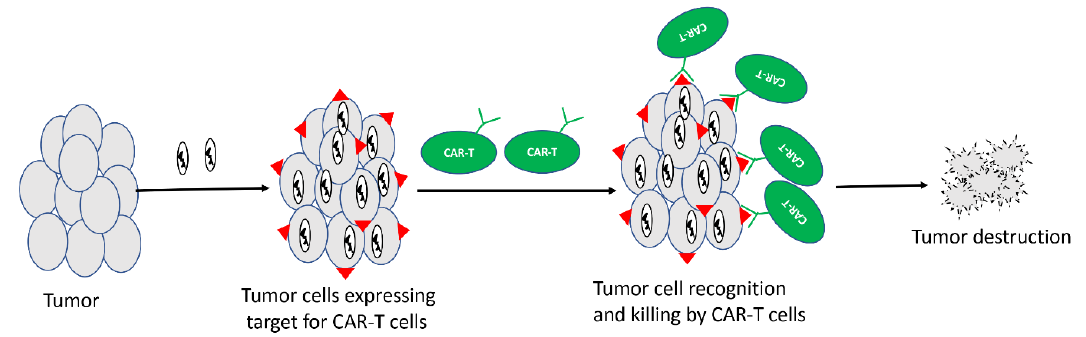
Figure 2. Oncolytic viruses delivering target for CAR-T cells. Unique antigens can be delivered to tumor cells using oncolytic virus, and CAR-T cells specific for that unique antigen can be used in combination to destroy tumors.